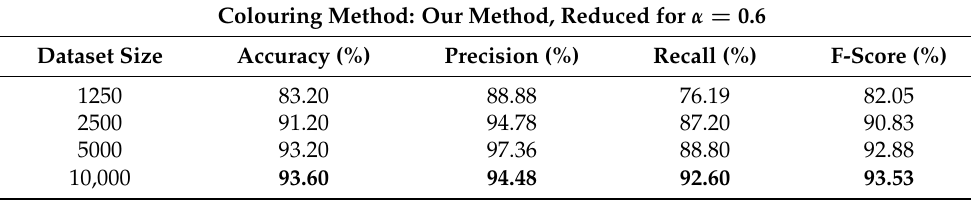
Table 10. Performance metrics for our method, processed with α = 0.6. Colouring Method: Our Method, Reduced for α = 0.6